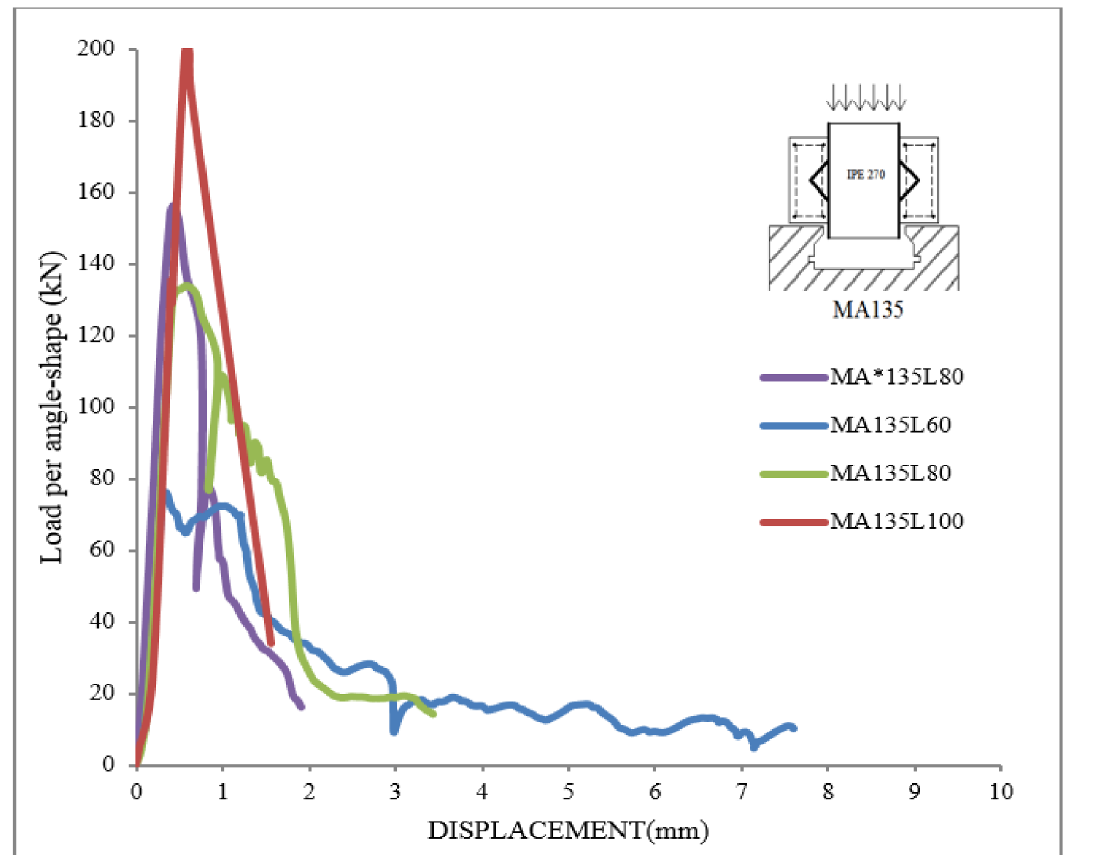
Fig 8. Load-displacement curves in specimens with tilt angle of 135.